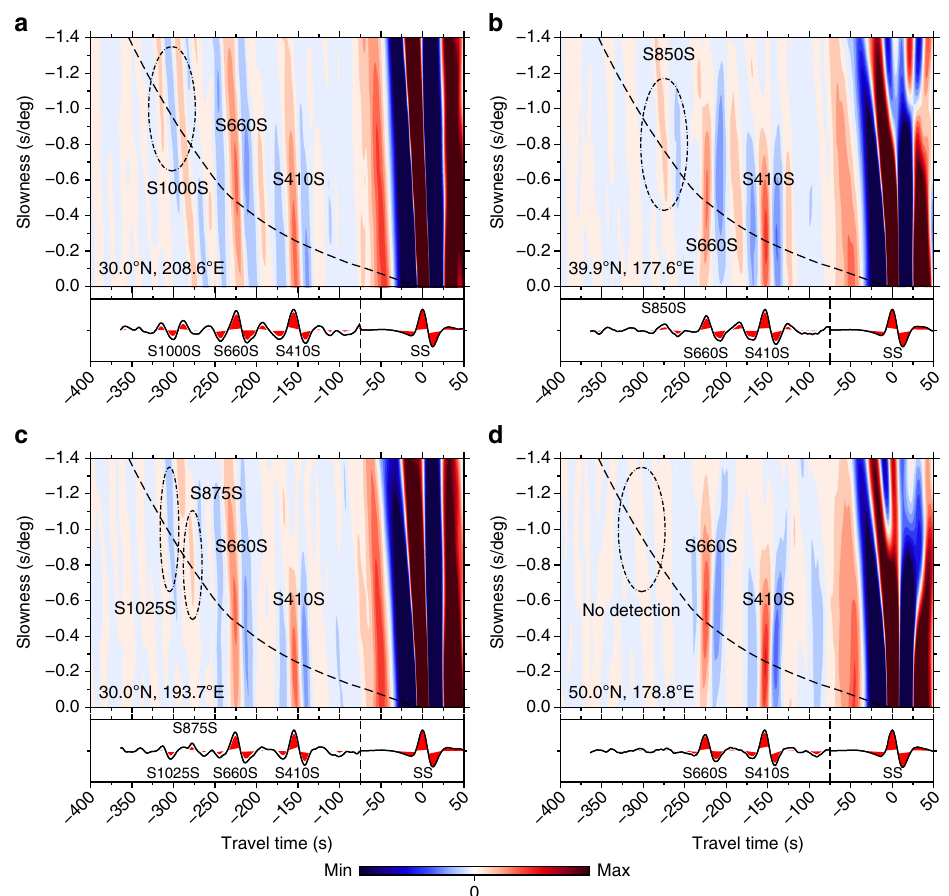
Fig. 2 Examples of vespagrams from 10° bins. a Negative polarity re fl ector (number of records, NR = 1492). b Positive polarity re fl ector (NR = 1486). c Multiple mid-mantle re fl ectors (NR = 1348). d No mid-mantle re fl ectors (NR = 1647), a non-detection. Areas of colour represent arrivals of coherent seismic energy from bootstrap resampling; colour scales normalised to SS amplitude. Slownesses are relative to the SS slowness of 12.56 s/° at 125°. Cross-sections are taken through the predicted arrival time and slowness of SS precursors (dashed line). Red peaks are 95% con fi dence